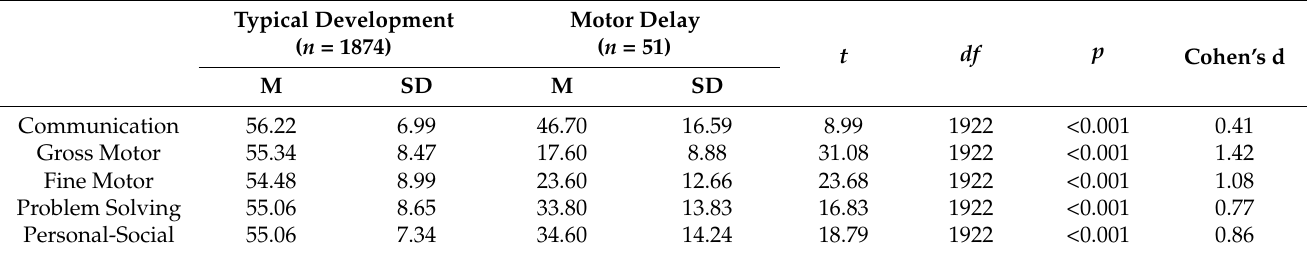
Table 10. Comparison group between children with Motor Delay and Typical Development on ASQ-3.